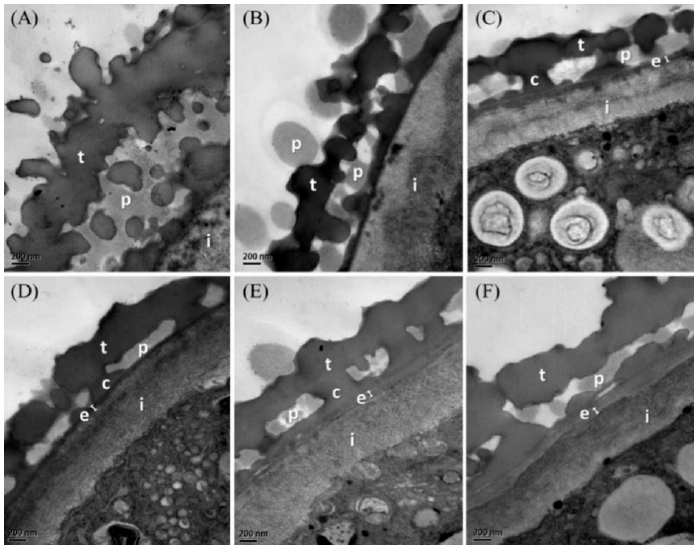
Figure 5. Structure of Quercus pollen walls under TEM. ( A ) Q. dentata , ( B ) Q. mongolica , ( C ) Q. aliena , ( D ) Q. variabilis , ( E ) Q. serrata , ( F ) Q. acutissima . Abbreviations: c, collumella; e, endexine; i, intine; p, pollenkitt; t, tectum. Scale bars represent 200 nm. Forests 2020 , 11 , x FOR PEER REVIEW